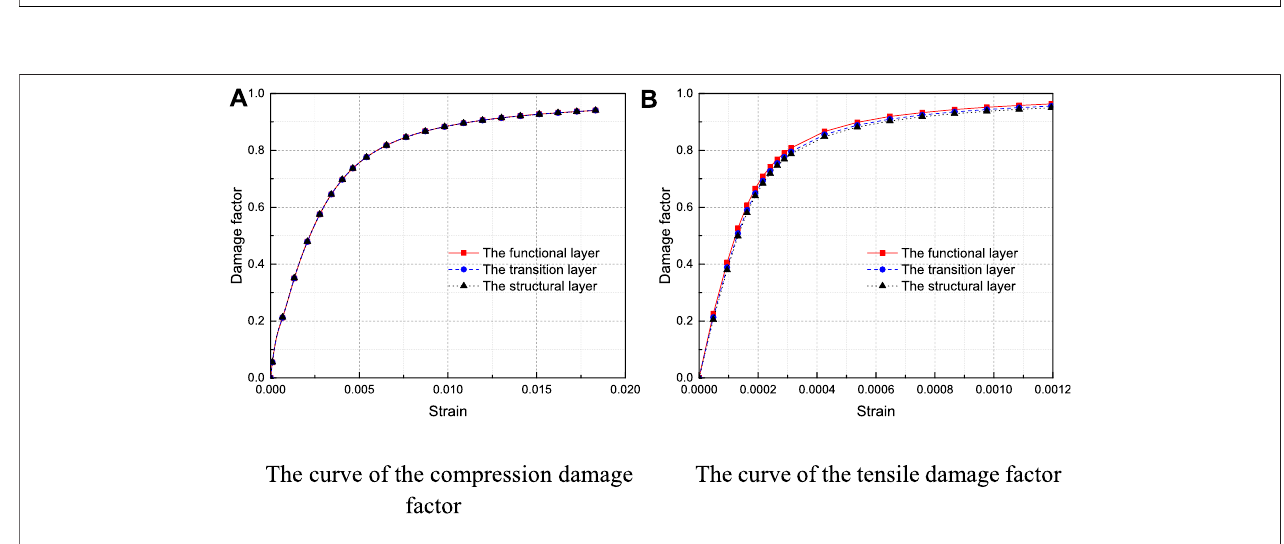
FIGURE 16 | The curve of the damage factor. (A) The curve of the compression damage factor. (B) The curve of the tensile damage factor.